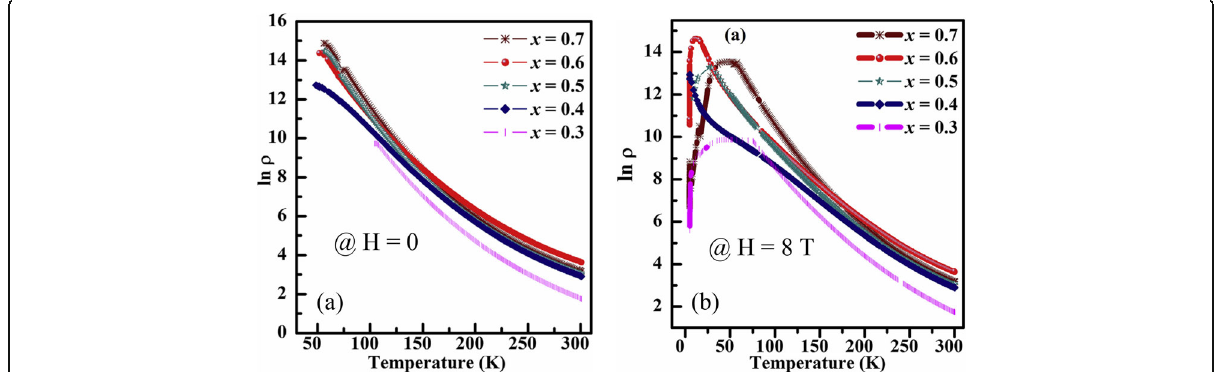
Fig. 27 Temperature dependent resistivity for the Nd 1-x Sr x MnO 3- δ nanoparticles under different external magnetic fields. a H = 0 and b H = 8 T. Reproduced with permission of [217]